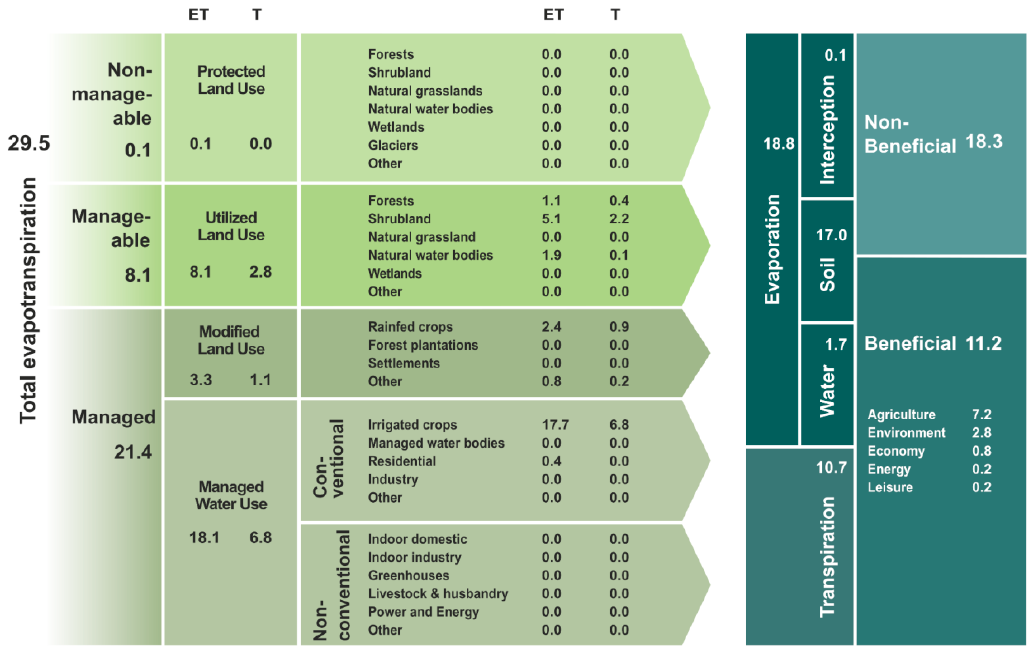
Figure 15. Sheet 2 was generated using WA+, with details of total water consumption in the basin for CHIRPS precipitation datasets, based on wet year (2016–2017).